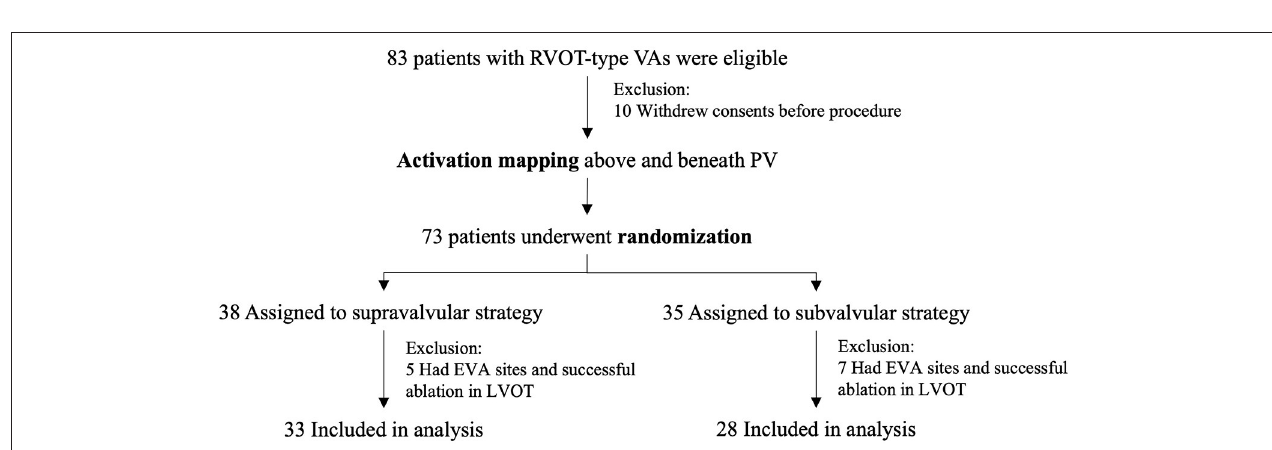
FIGURE 3 | Patient flow and randomization. EVA, earliest ventricular activating; PV, pulmonary valve; PVC, premature ventricular contraction; RVOT, right ventricular outflow tract; VA, ventricular arrhythmia.